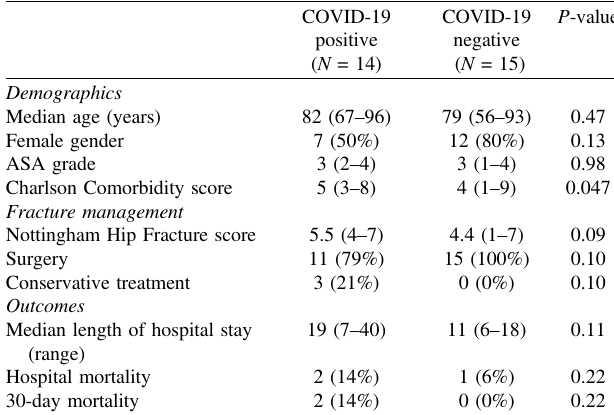
Table 1. Comparison between COVID-positive and negative femoral neck fracture